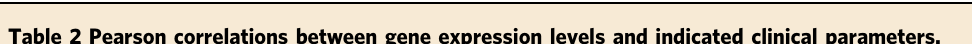
Table 2 Pearson correlations between gene expression levels and indicated clinical parameters.